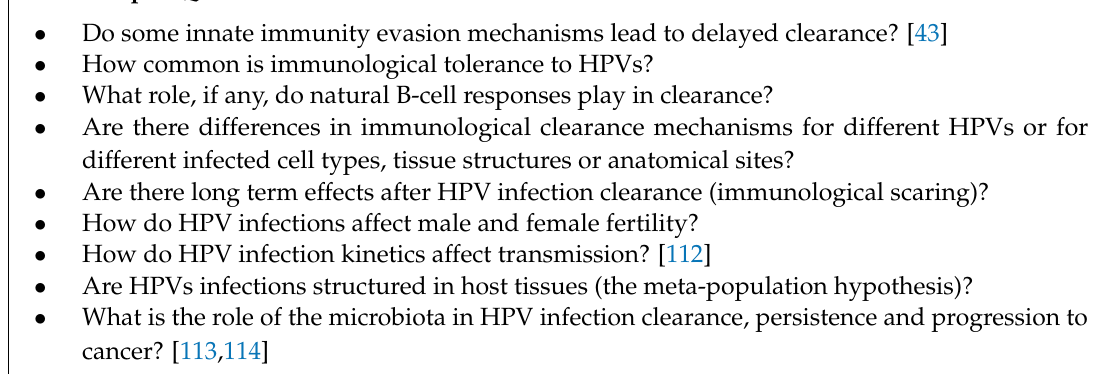
Table S1: HPV epidemiological data for Figure